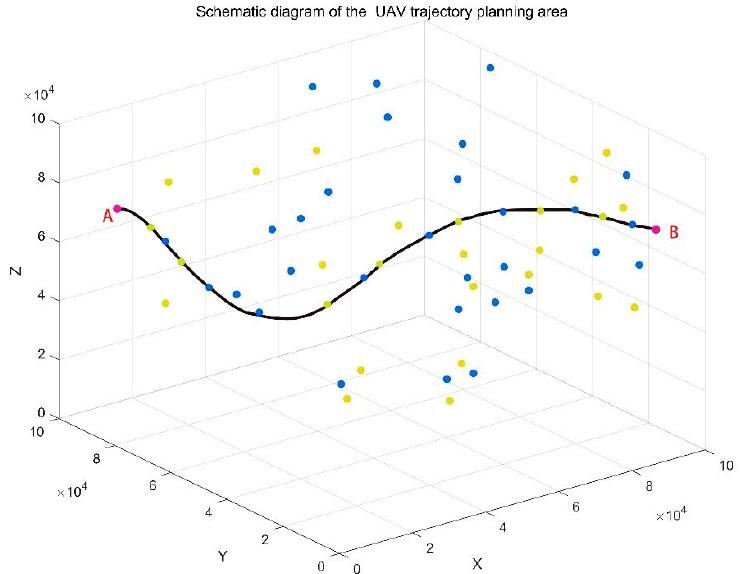
Figure 1. Schematic diagram of an UAV trajectory planning area. The yellow points are the horizontal error correction point, the blue points are the vertical error correction point, the starting point is point A, and the destination is point B. The black curve represents a trajectory. (3) At the starting point A, the vertical and horizontal error of an UAV are both zero. (4) After the correction of the vertical error correction point, the vertical error will become zero and the horizontal error will remain unchanged. zero and the vertical error will remain